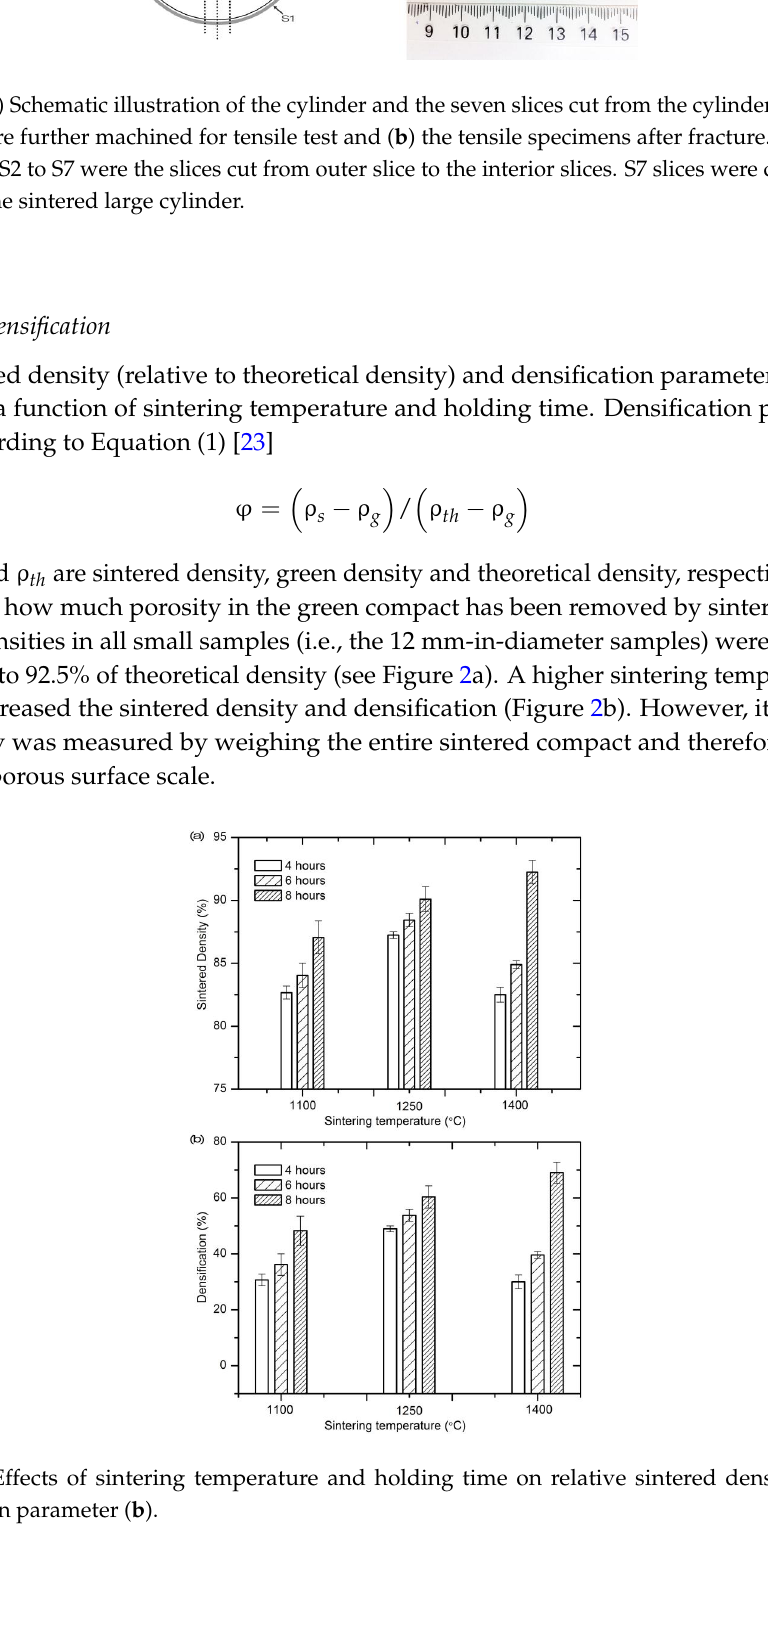
Figure 1. ( a ) Schematic illustration of the cylinder and the seven slices cut from the cylinder, only slices S3 to S7 were further machined for tensile test and ( b ) the tensile specimens after fracture. S1 was the outer scale, S2 to S7 were the slices cut from outer slice to the interior slices. S7 slices were cut from the central of the sintered large cylinder.